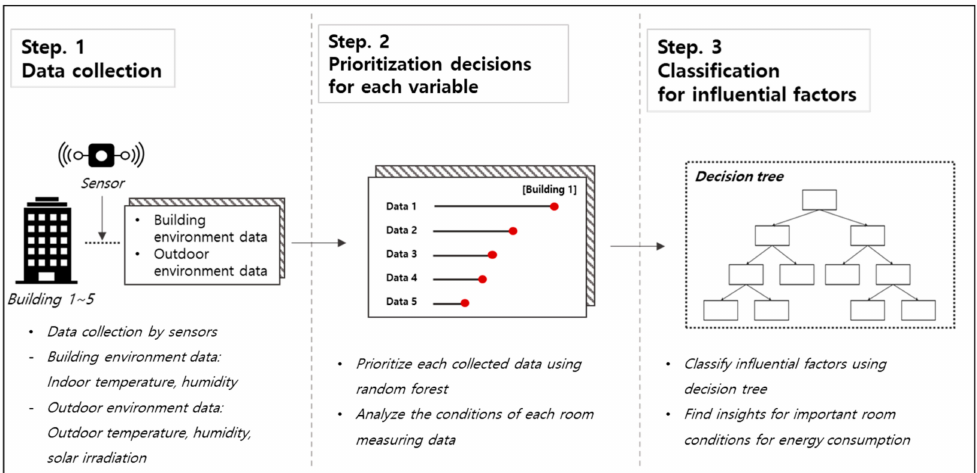
Figure 1. Flow chart of research